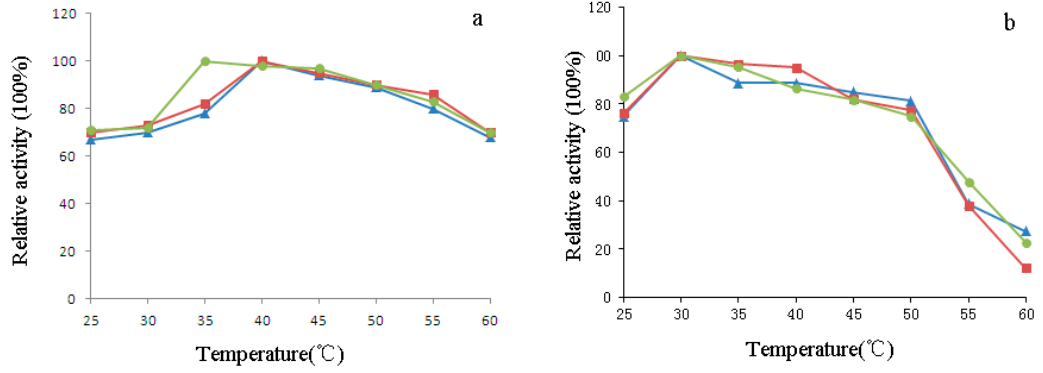
Figure 8. Effect of temperature on uricolytic activity ( a ) and stability ( b ) of wPU ( ▲ ), PBC ( ■ ), and H 1-2 P 3 H 4 P 5-6 H 7-8 (E24D & E83G) ( ● ). Enzyme activity at the optimum temperature (activity) or at the beginning of incubation (stability) was assumed to be 100%.